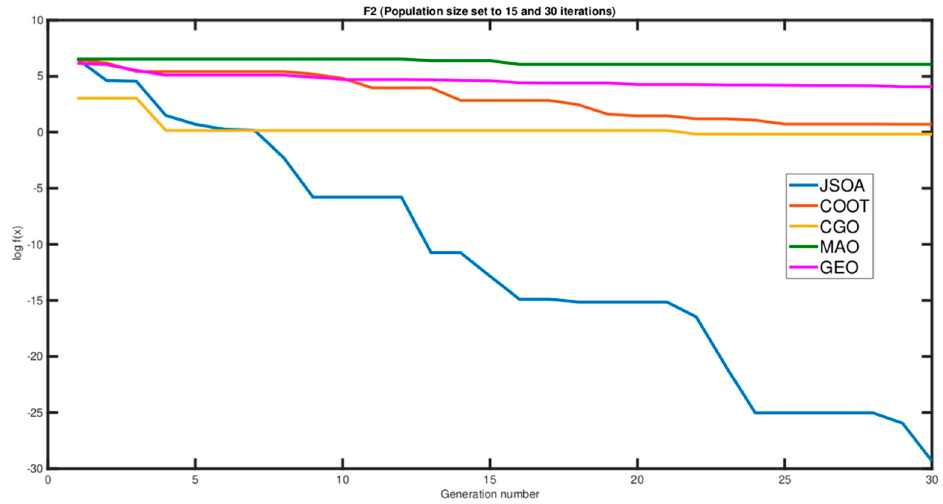
Figure 9. Convergence graph of the population size analysis as